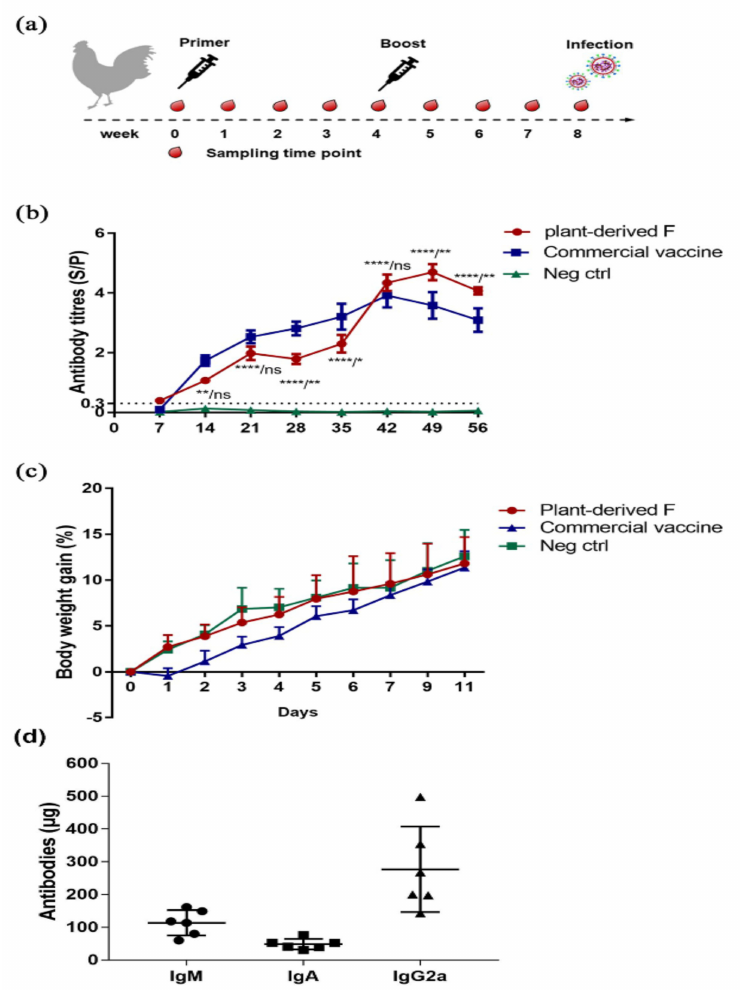
Figure 3. Humoral immune responses of plant-produced F. ( a ) Scheme of immunization, virus infection, and sampling. ( b ) The F-specific antibody titers in the plant-produced F vaccine and commercial live virus vaccine (LaSota strain) were detected by ELISA kits. According to the instructions, the cut-o ff value of S / P is 0.3. Data are shown as the means ± SEM from ten chickens. Statistical analysis was performed by two-way ANOVA. Di ff erential markers are labelled according to the significant di ff erence between plant-produced F protein and non-transgenic rice / significant di ff erence between plant-produced F protein and commercial live virus vaccine, where “ns” represents no significant di ff erence, * indicates p < 0.05, ** p < 0.01, and *** p < 0.001. ( c ) Weight gain after vaccination with plant-derived F, PBS and commercial live vaccine. ( d ) Analysis of antibody subtypes in sera from the chicken vaccinated with the plant-produced F vaccine. IgM are shown as circles, IgA as squares, and IgG2a as